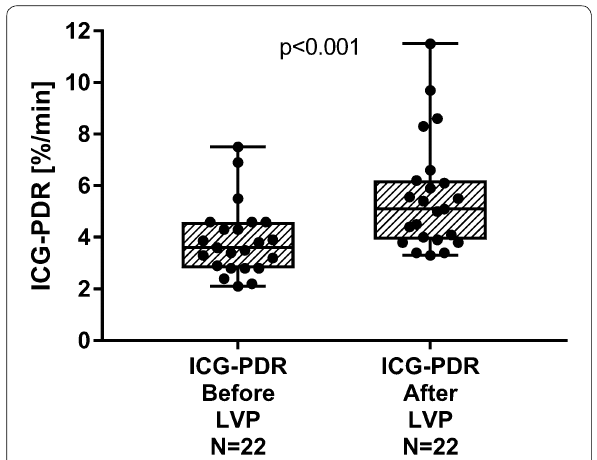
Fig. 1 ICG‑PDR at baseline and after large‑volume paracentesis (LVP), depicted as box plots (median and IQR, min to max) and showing all individual